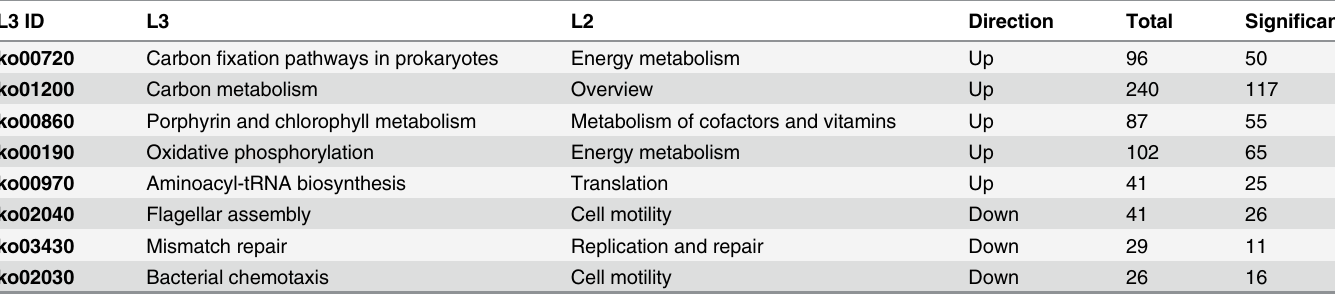
Table 4. Biochemical pathways with over representations of ortholog groups with significant time effects. L3